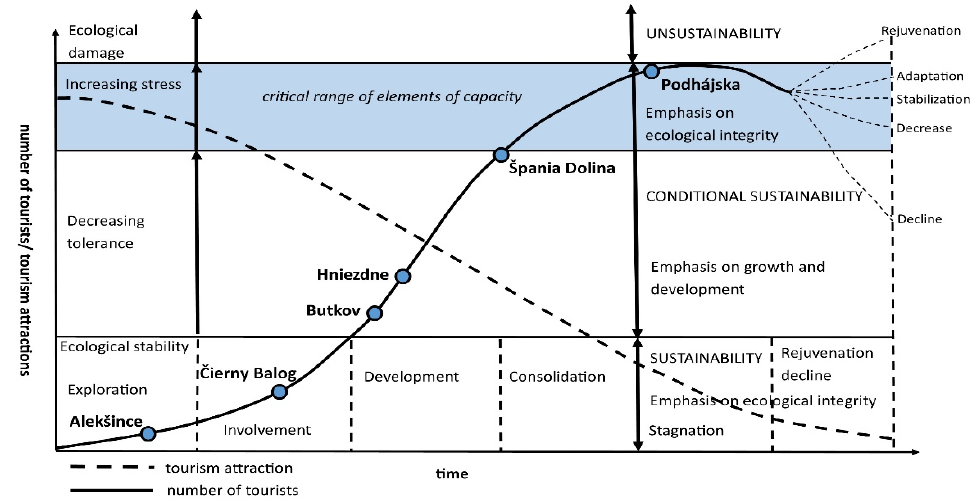
Figure 10. Life cycle of transformed tourism localities in Slovakia concerning sustainable development. Source: [33,42], own processing, 2021.